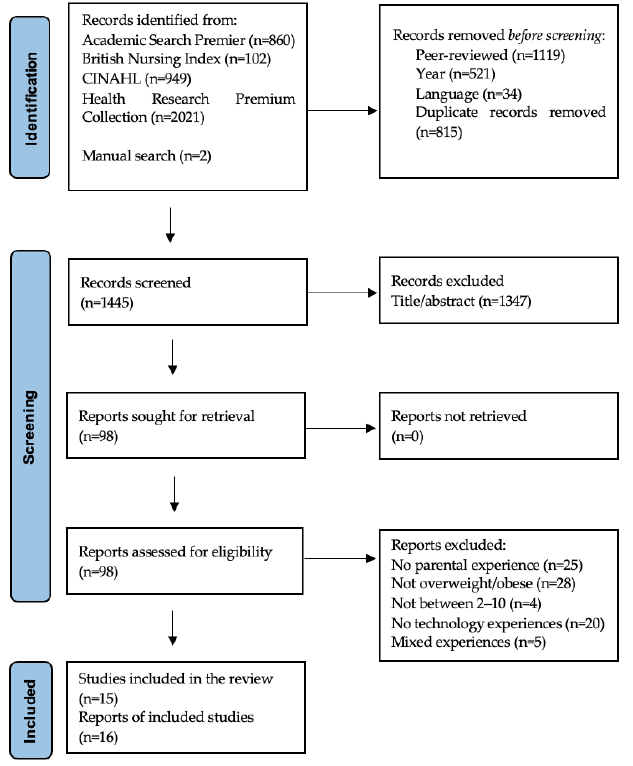
Figure 1. PRISMA flowchart [29]. See Table A1 for the full search